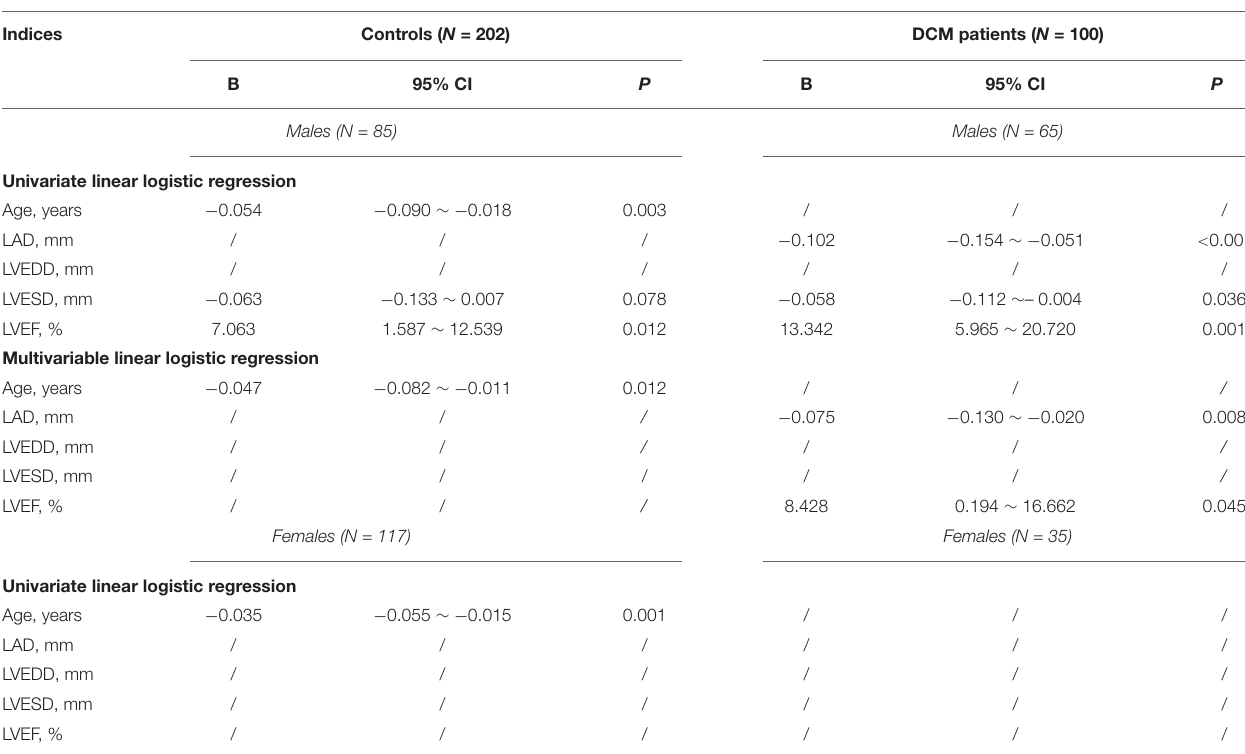
TABLE 3 | Factors associated with DC in controls and patients with